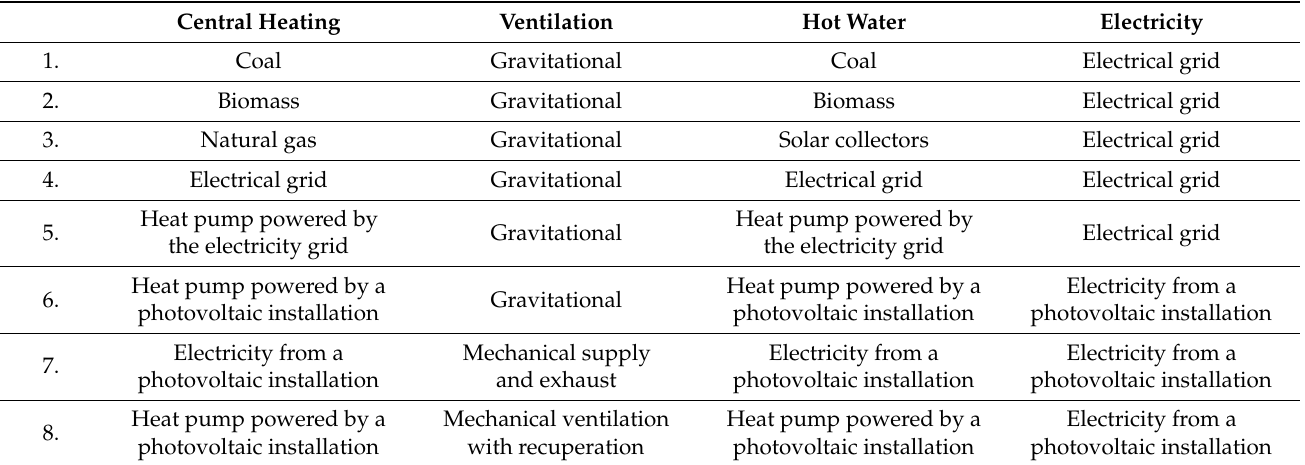
Table 3. List of variants of the analyzed models in central heating, hot water, ventilation and electricity installations for the analyzed building (own